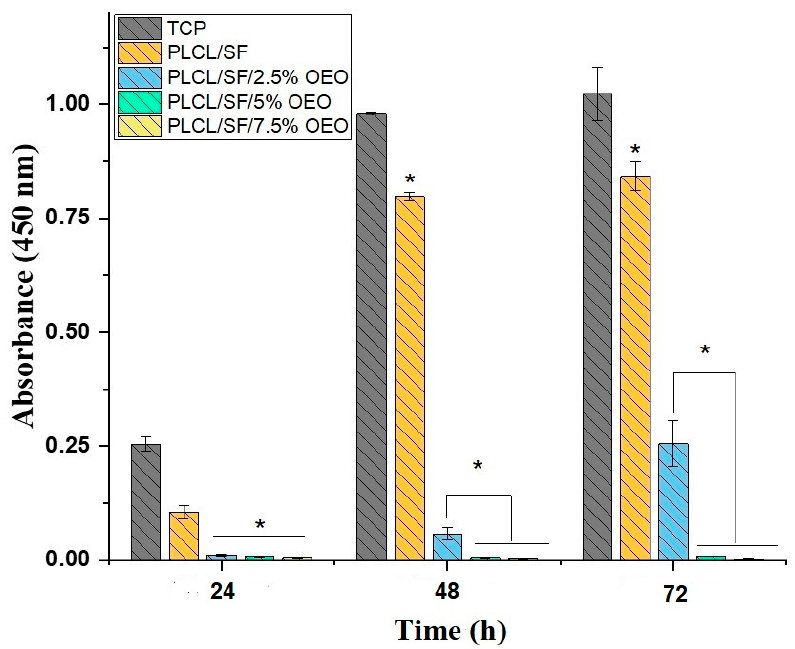
Figure 9. Cell counting Kit-8 (CCK-8) result of 4T1 cell line proliferation on NF membranes (* = significant difference; p < 0.05 n = 3).